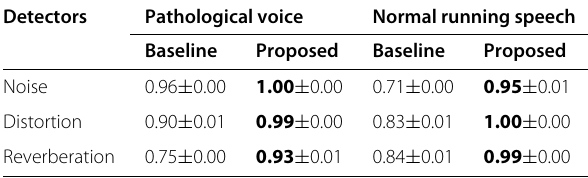
Table 3 Comparison between the proposed method for degradation detection and the baseline system for pathological voice and normal running speech